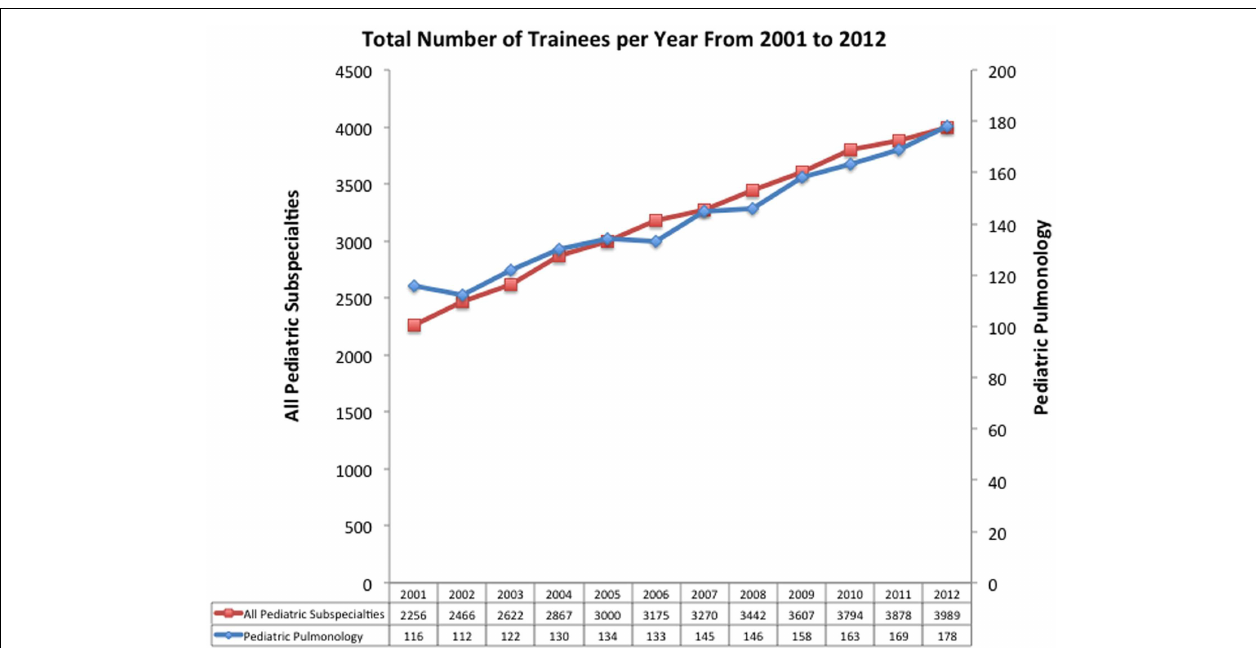
FIGURE 1 |Total numbers of trainees by year in all pediatric subspecialties and in pediatric pulmonology . Adapted from data published by the American Board of